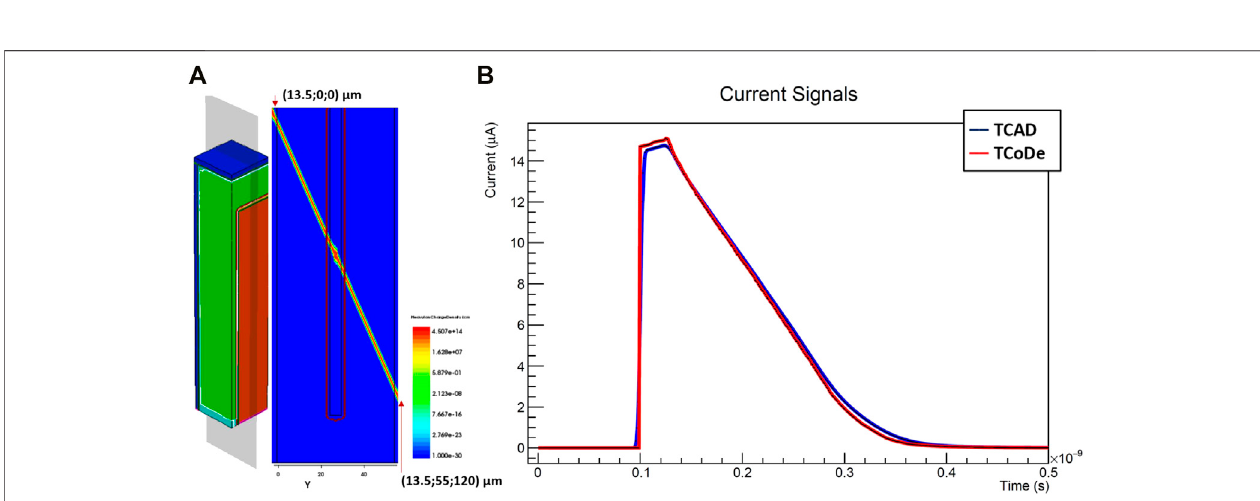
FIGURE 4 | Comparison of TCoDe and TCAD simulated currents (B) for an energy deposit producing roughly 12 k charge carriers on a TimeSPOT silicon sensor (A) .